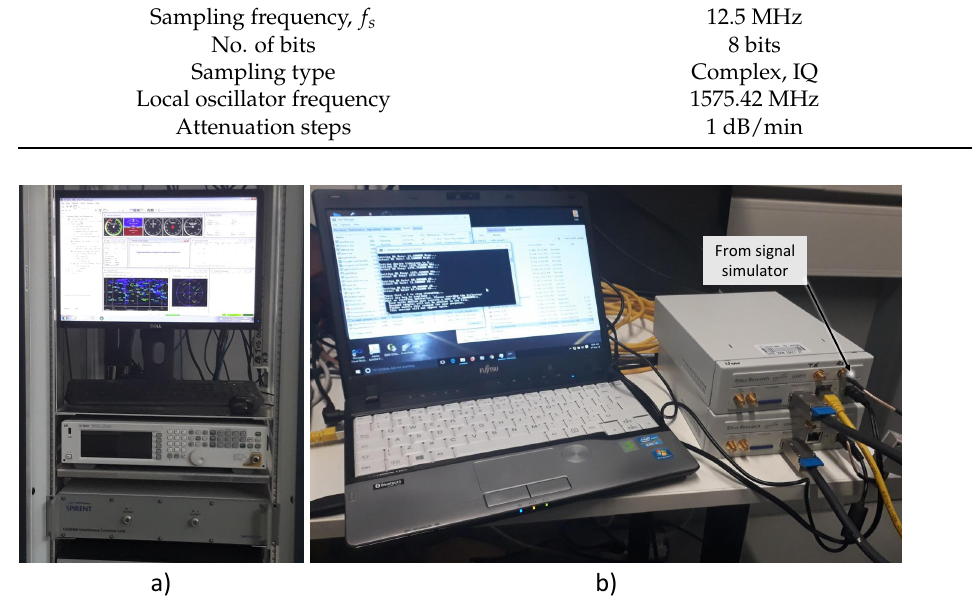
Figure 6. Experimental setup adopted for the collection of the I/Q samples generated using a Spirent GSS9000 simulator. ( a ) View of the Spirent GSS9000 simulator. ( b ) View of the USRP II adopted for signal